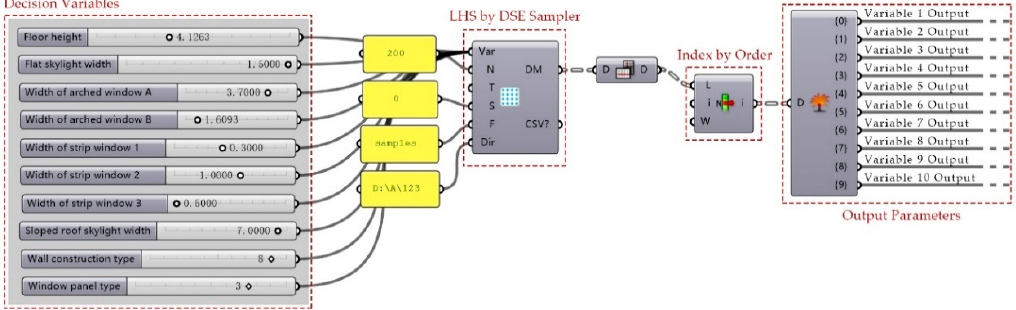
Figure 5. Latin Hypercube Sampling module.